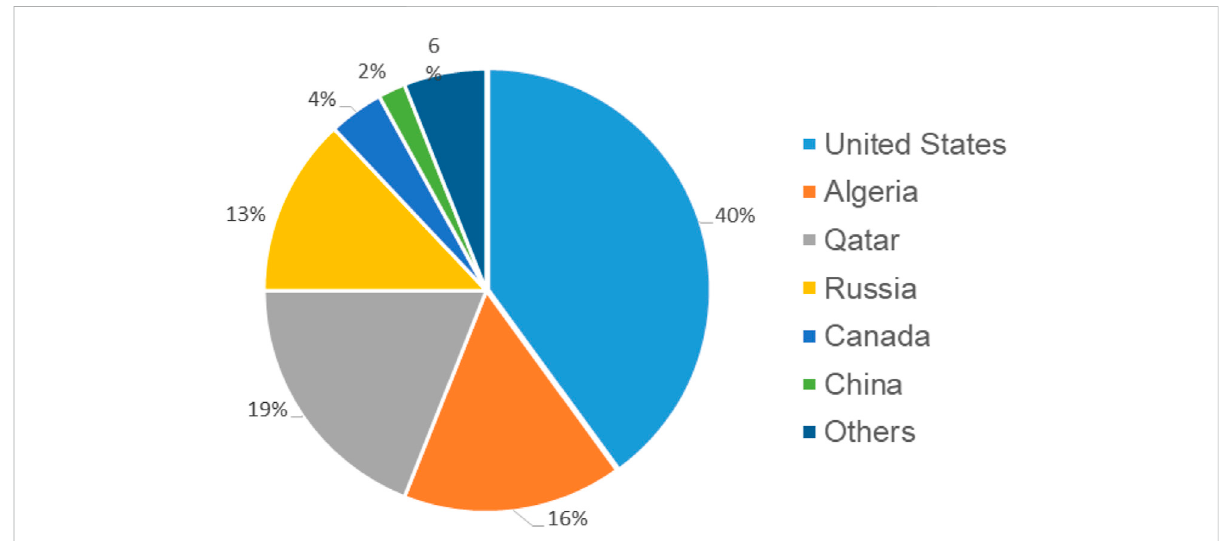
FIGURE 1 Forecast of helium resources in the world (data from USGS, 2021) (Thor Resources Inc,